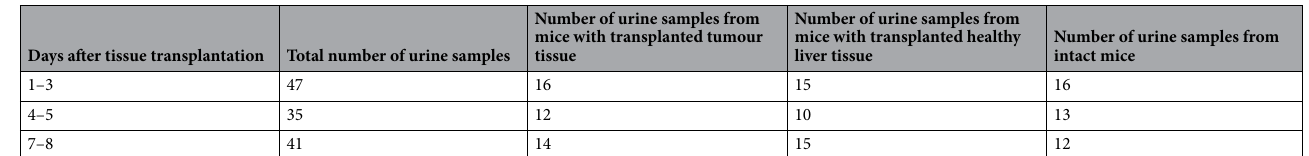
Table 5. Urine samples spreading over the days after tissue